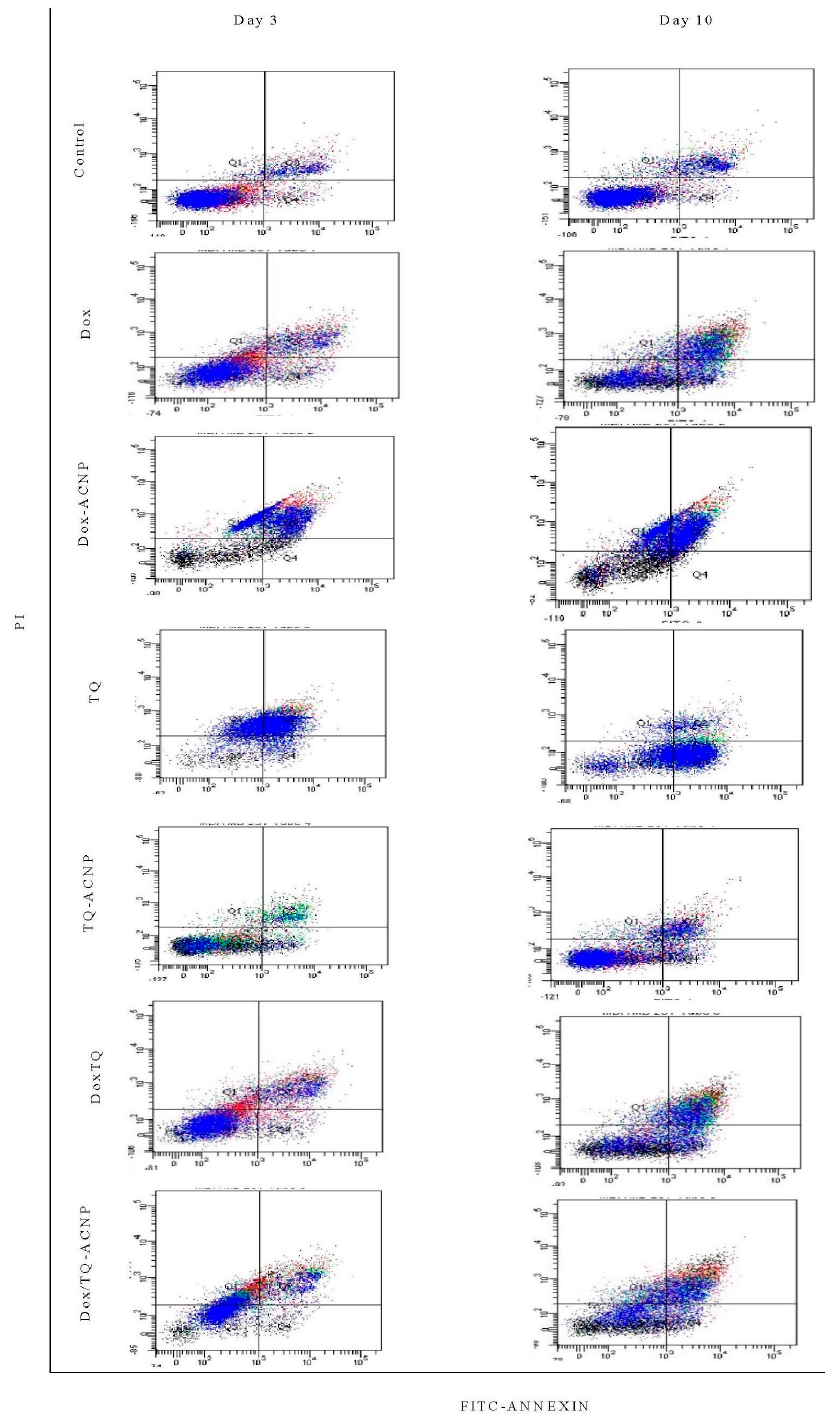
Figure 7. Flow cytometry results of cytopathology in control and treated 3D mammosphere cells; percentages of viable cells (Q3), early apoptosis (Q4), late apoptosis (Q2) and necrosis (Q1) at day 3 and day 10.